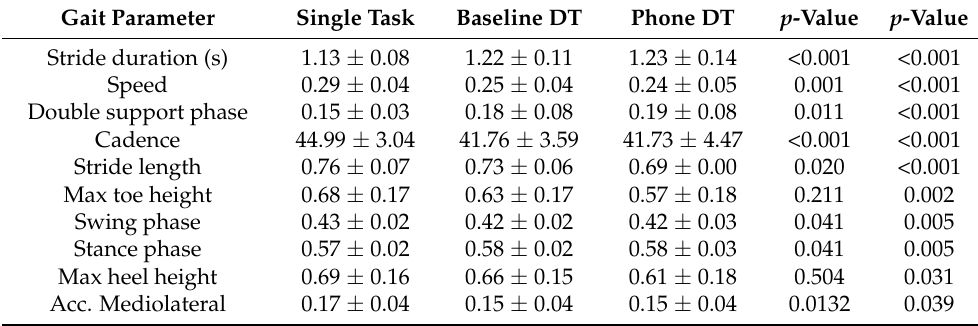
Table A1. Results of applying the student’s t -test for each gait parameter normalized between single task (only gait) and gait during dual-tasking (baseline and mobile device tasks). Variables are sorted in ascending order of p -values. The mean ± SD of the parameters are reported.